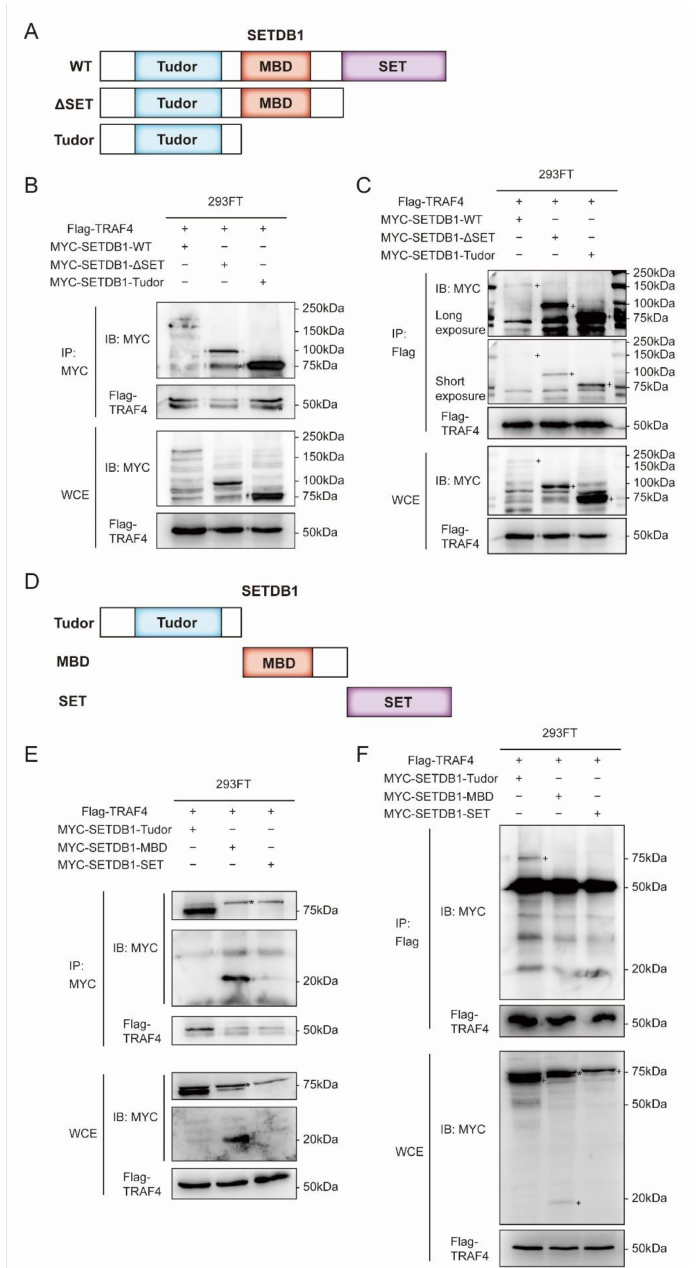
Figure 5. TRAF4 only interacts with the Tudor domain of SETDB1. ( A ) Schematic representation of full-length and deleted fragments of SETDB1. ( B , C ) 293FT cells infected with Flag-TRAF4 and MYC- SETDB1-WT/MYC-SETDB1- ∆ SET/MYC-SETDB1-Tudor were immunoprecipitated with ( B ) anti- MYC antibody/( C ) anti-Flag antibody, followed by immunoblotting. The interaction of TRAF4 with deleted fragments of SETDB1 ( ∆ SET and Tudor) were examined. ( D ) Schematic representation